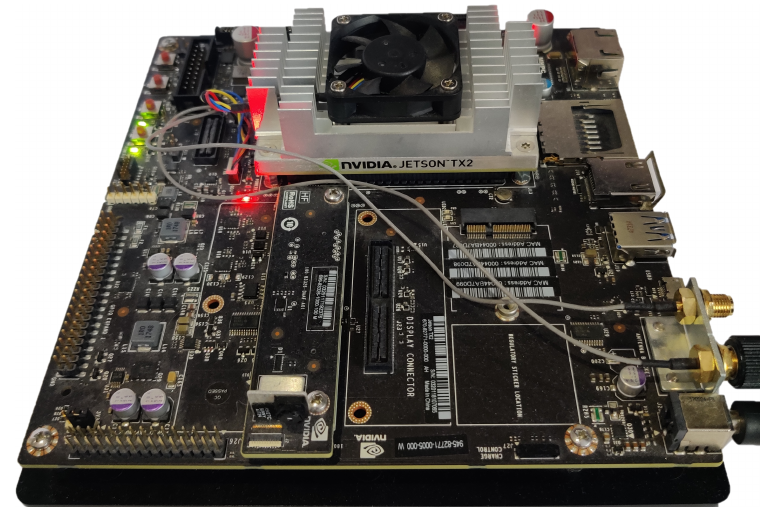
Figure 2. NVIDIA Jetson TX2 developer